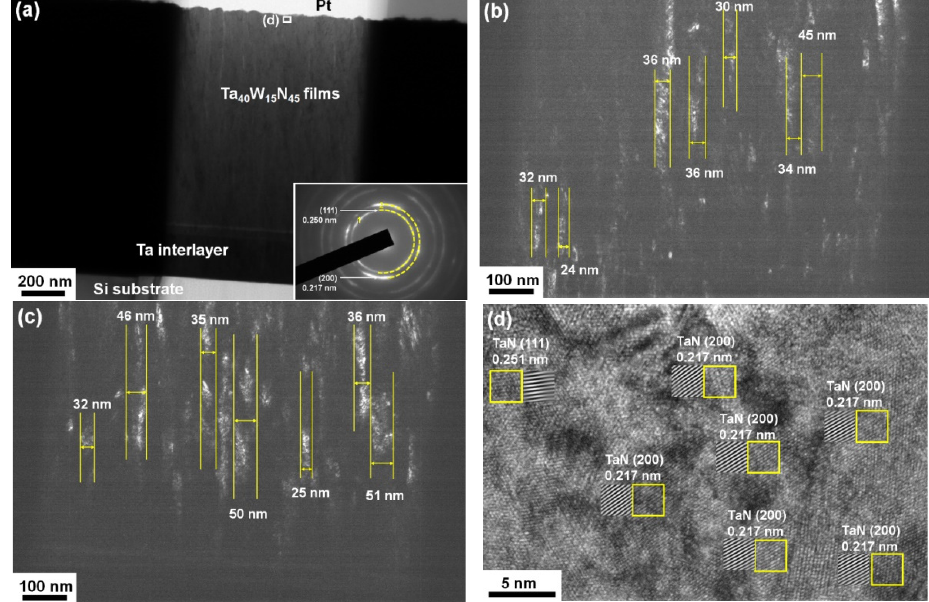
Figure 2. ( a ) XTEM image and SAED pattern, dark-field images corresponding to the ( b ) (111) and ( c ) (200) spots in SAED pattern and ( d ) HRTEM image of the Ta 40 W 15 N 45 film.